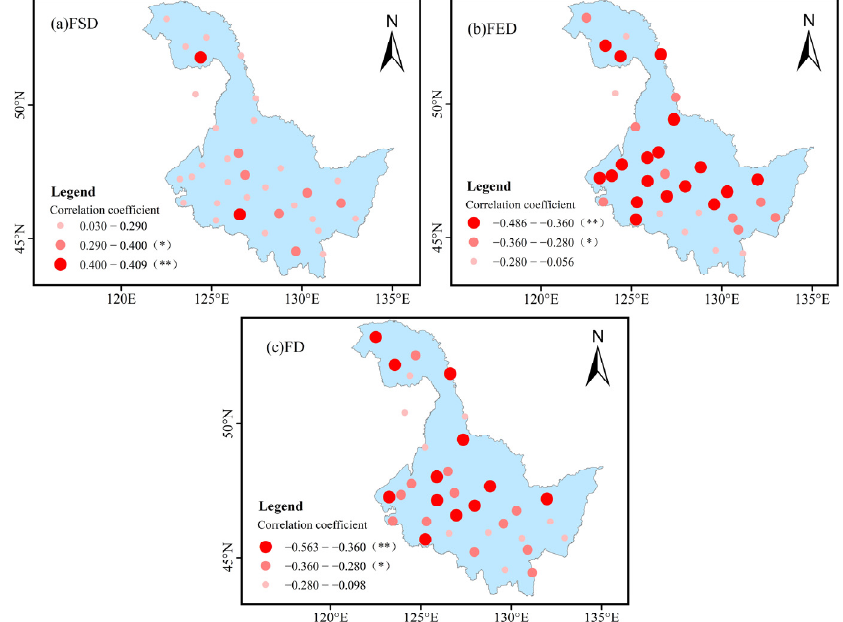
Figure 6. Spatial distribution of correlation coefficients between annual mean temperature and key variables in Heilongjiang Province (* indicates reaching a significance level of α = 0.05 and ** indicates reaching a significance level of α = 0.01).